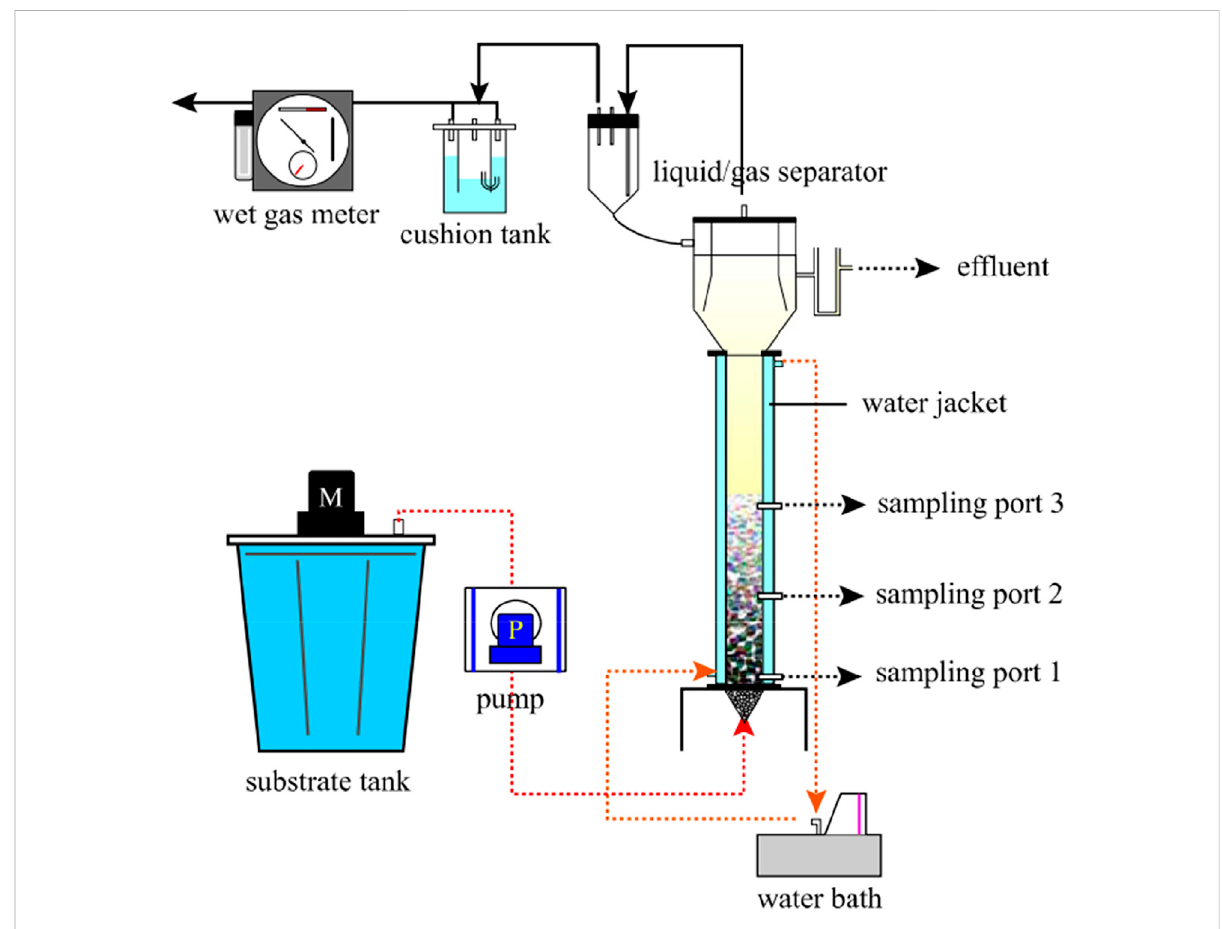
FIGURE 3 Schematic diagram of the UASB reactor (Akutsu et al.,